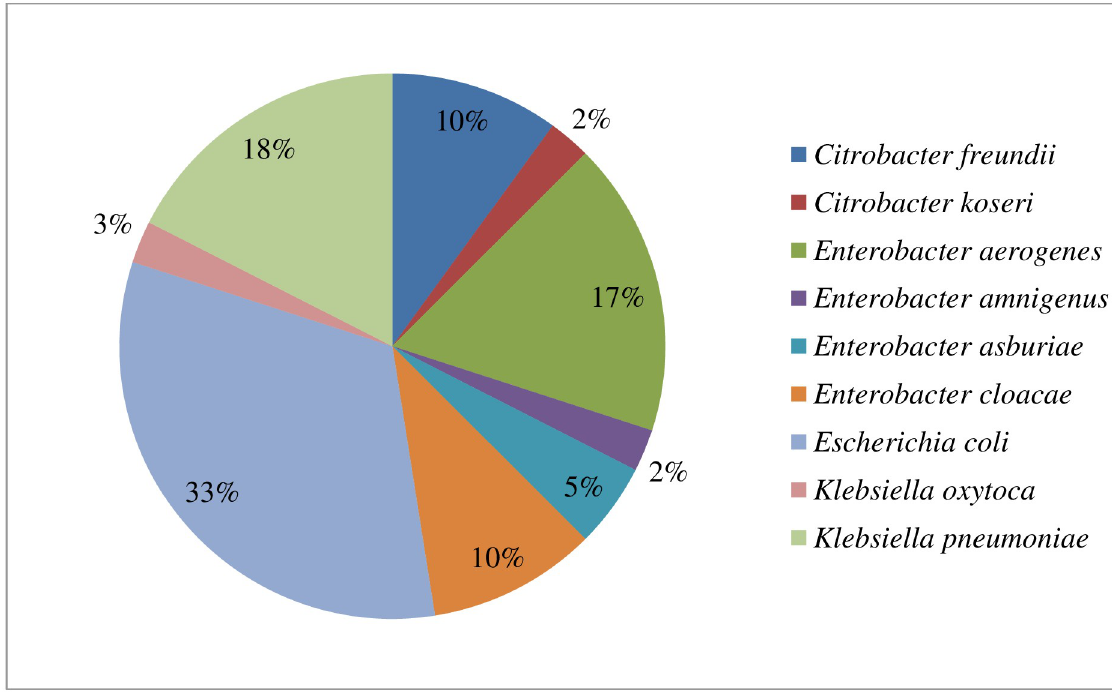
Fig 3. The distribution of the confirmed members of the targeted Enterobacteriaceae (n = 40) recovered from the